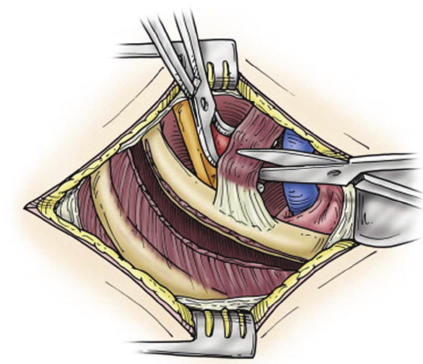
Figure 5: Transection of the anterior scalene muscle with a right angle clamp and scissors (reprinted with permission of Elsevier; see